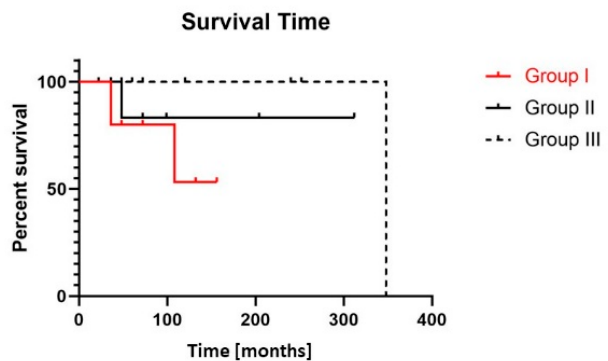
Figure 3. Patients with LCT show a reduced overall survival. Overall survival (Kaplan–Meier curve) of patients of groups I (MF with LCT) ( n = 10), II (aggressive MF without LCT) ( n = 10) and III (indolent MF without LCT) ( n = 7) from date of first diagnosis of MF. Overall survival of group I versus II p = 0.4 and group I versus III p = 0.06 (log-rank test).